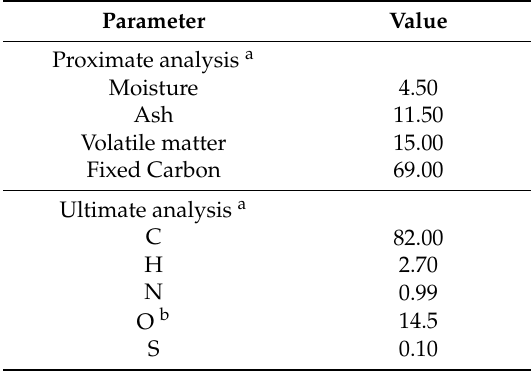
Table 1. Chemical characteristics of activated carbon